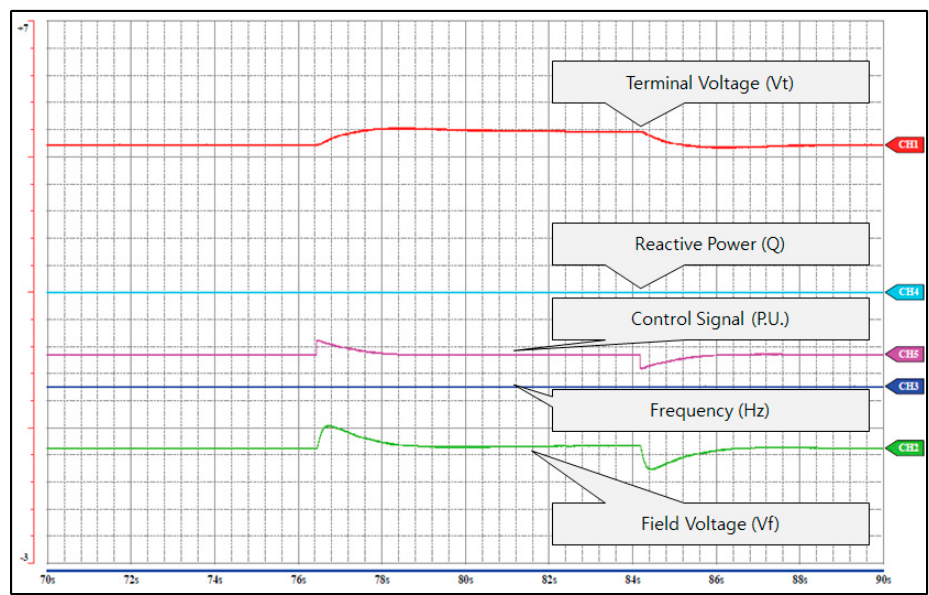
Figure 18. Waveform resulting from 5% step-response test in auto mode (No-load state).